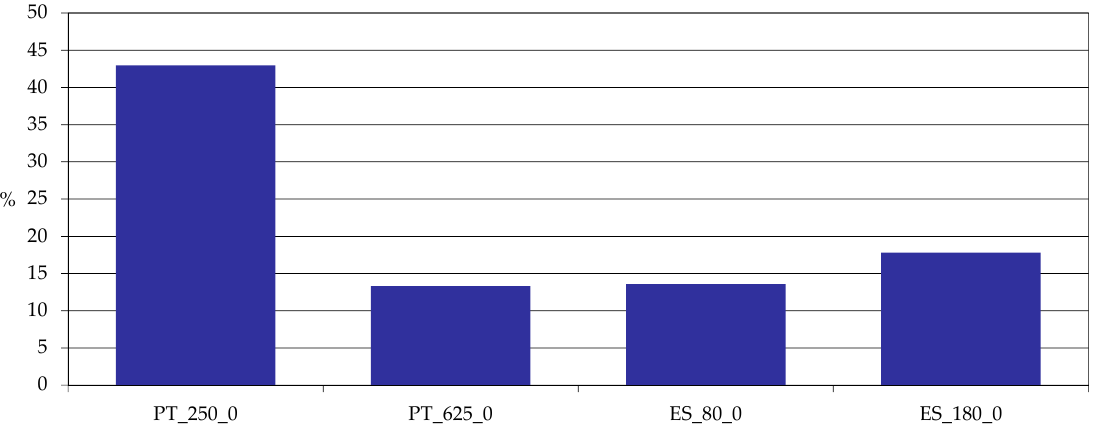
Figure 2. Profit margin whole farm (% share of farm income in total returns). Source: model results.